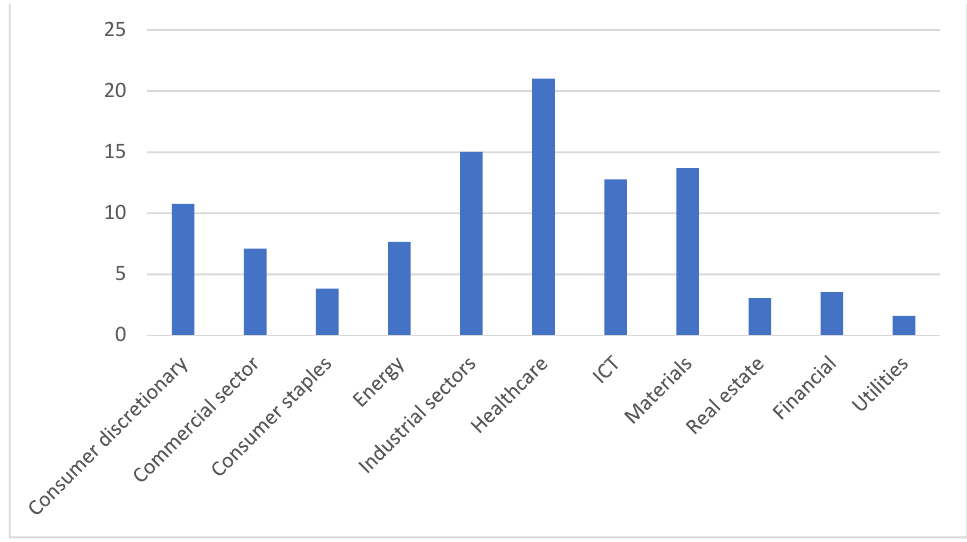
Figure 4. Share of listed companies in Europe with an interest coverage ratio less than 1 per sector (%, 2022). Note: the total number of companies listed 162,841, while the share of zombie firms within was 3.7% (6039). Source: own compilation based on finbox.com database.